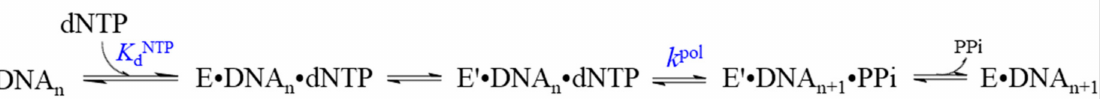
Figure 9. Three-dimensional structure of HIV-1 reverse transcriptase (RT) heterodimer in complex with a double stranded RNA (PDB ID 6hak). The thumb (green), palm (red), fingers (blue), RNase H (grey), and connection (yellow) domains are